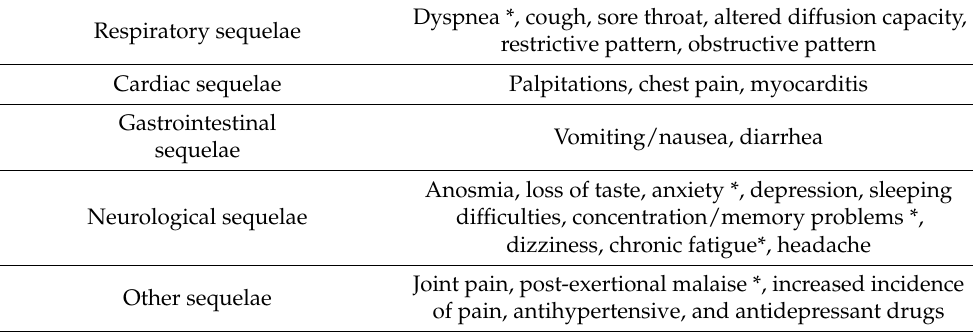
Table 1. Summary of the described manifestations of PCS; (*) represents the most commonly reported symptoms